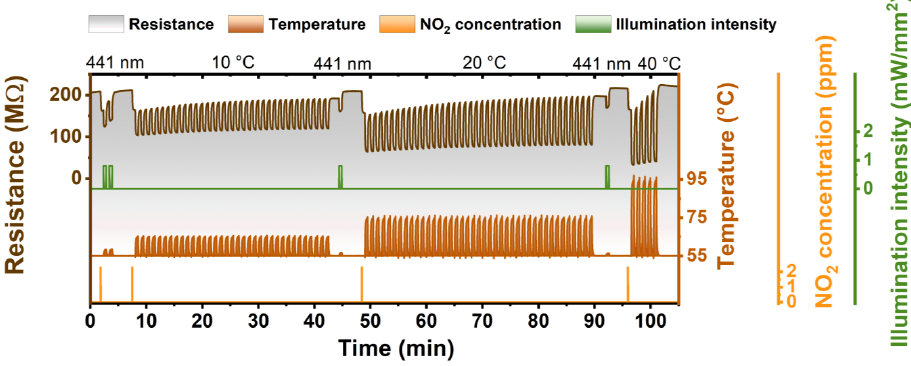
Figure 6. Comparison of photoregeneration and temperature regeneration under dark conditions–sequence of one photo- regeneration cycle (pulses of 30 s of illumination and 30 s of waiting) and three different (10, 20, and 40 °C) temperature regeneration cycles (pulses of 30 s of raised temperature and 30 s of waiting) after NO 2 exposure.